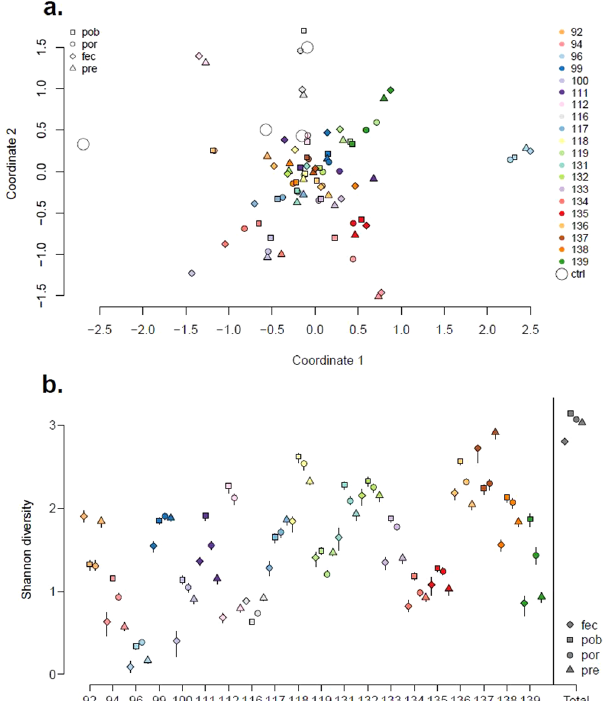
Figure 1. gnd sequence type (gST) clustering and diversity at the animal and library level. (a ) Clustering of gSTs obtained from 20 calves and four control samples using multi-dimensional scaling plot to illustrate the gST similarity derived from each of the four extraction methods (pre-enrichment, ‘pre’; post-enrichment boiled lysate, ‘pob’; post-enrichment, spin-column, ‘por’ and faecal, ‘fec’) for each animal and 4 mock libraries. The MDS plot provides a visual representation of the distance matrix encompassing the similarity of gSTs found in each of the 84 libraries, i.e. four extraction methods (symbol shape) and 20 animals (symbol colour). Symbols close together indicate libraries containing similar gSTs; symbols far apart indicate libraries containing dissimilar gSTs. ( b ) Diversity of gSTs obtained from 20 calves using Shannon Index to illustrate the number of different gSTs and the variation in gST relative abundance obtained from each of the four extraction methods (pre-enrichment, ‘pre’; post-enrichment boiled lysate, ‘pob’; post-enrichment, spin-column, ‘por’ and faecal, ‘fec’) for each animal. Sequence data obtained from the four libraries originating from calf 96 contained between 3 and 13 different gSTs; in contrast sequence data obtained from the four libraries originating from calf 137 contained between 40 and 82 different gSTs. The total gST diversity across the 80 libraries is illustrated on the right of the x axis. The error bars represent 95% confidence